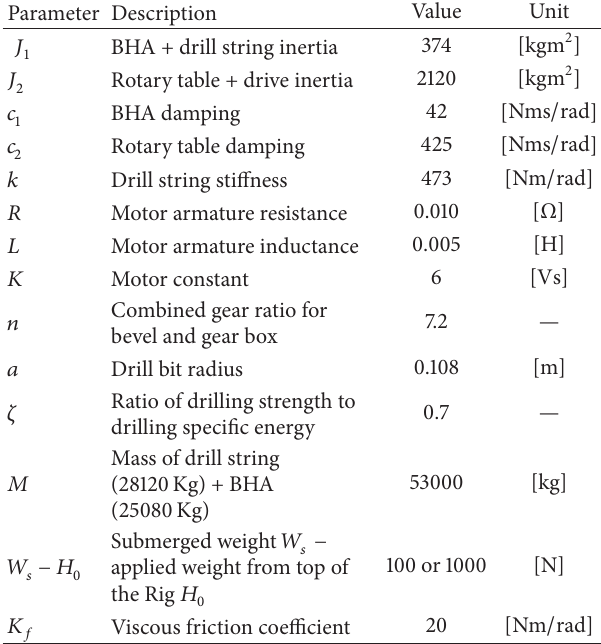
Table 1: Numerical values for drilling system